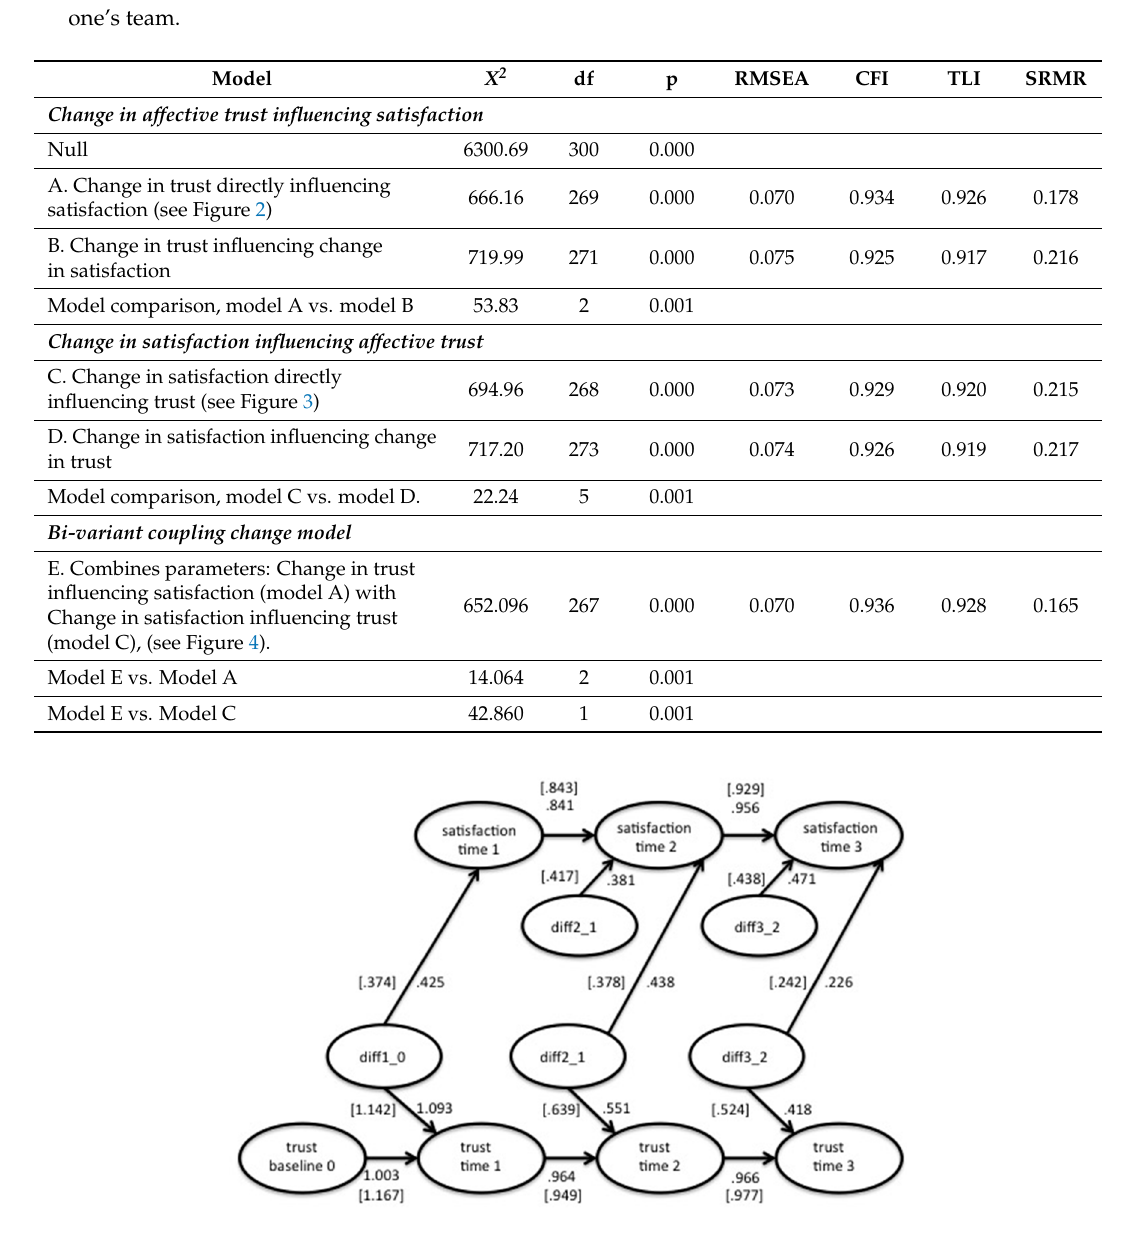
Figure 2. Latent change in trust influencing satisfaction with one’s team. Standardized parameter estimates for affective trust are not bracketed, those for cognitive trust are given in brackets. All estimates are significant p < 0.01. For clarity, the measurement model and indicator specific latent variables are not presented .